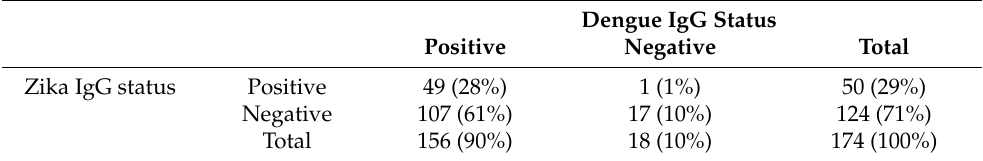
Table 3. Association between Zika IgG and Dengue IgG. Dengue IgG Status Positive Negative Total Zika IgG status Positive 49 (28%) 1 (1%) 50 (29%) Negative 107 (61%) 17 (10%) 124 (71%) Total 156 (90%) 18 (10%) 174 (100%) p -Value from McNemar’s test <